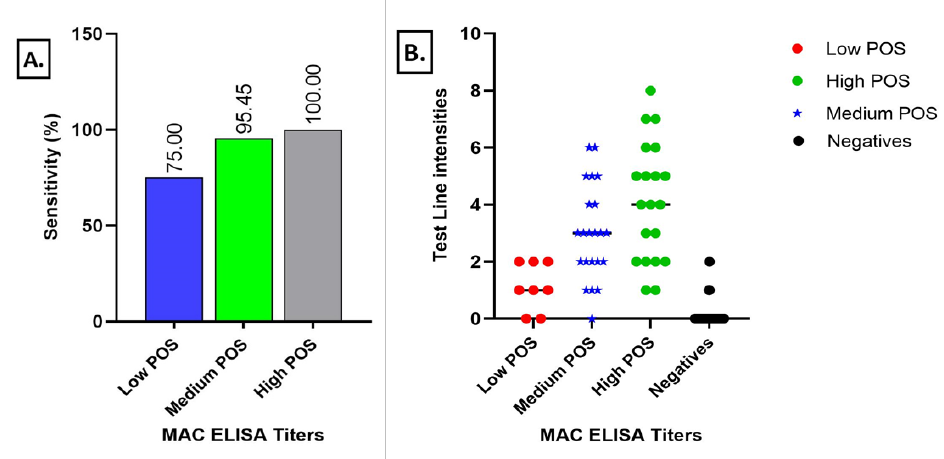
Figure 4. Sensitivity of the IgG/IgM RDT versus ELISA IgM ratio ( A ) and MAC ELISA titres ( B ).